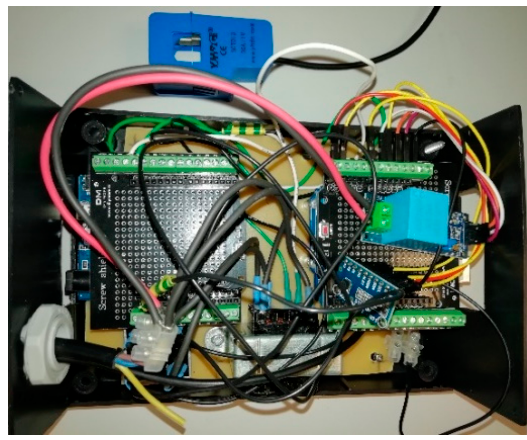
Figure 1. OSPPSM prototype.